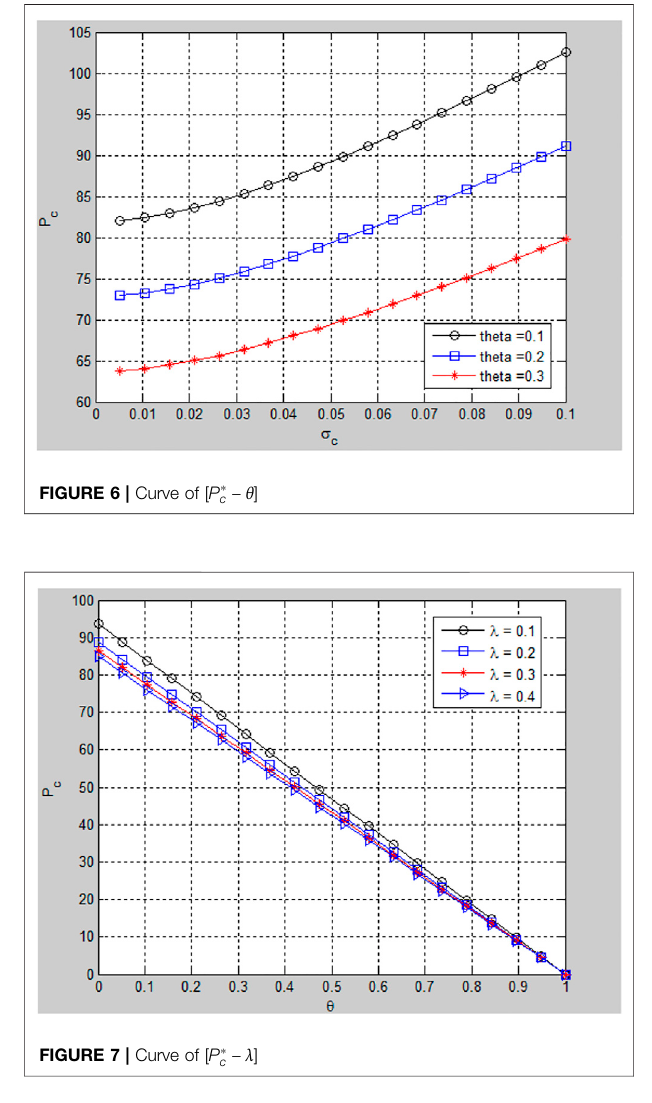
Frontiers in Energy Research |